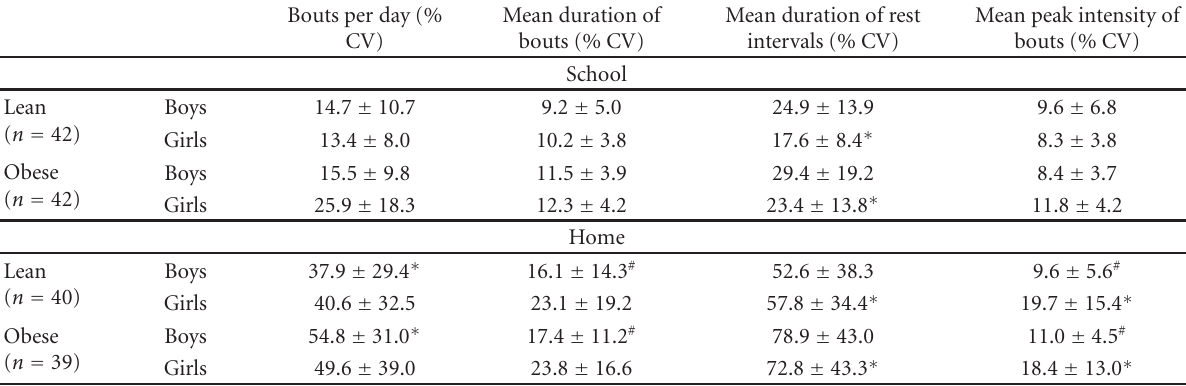
Table 4: Intra-individual variation in the activity pattern characteristics at school and at home, by weight status and sex. Bouts per day (%